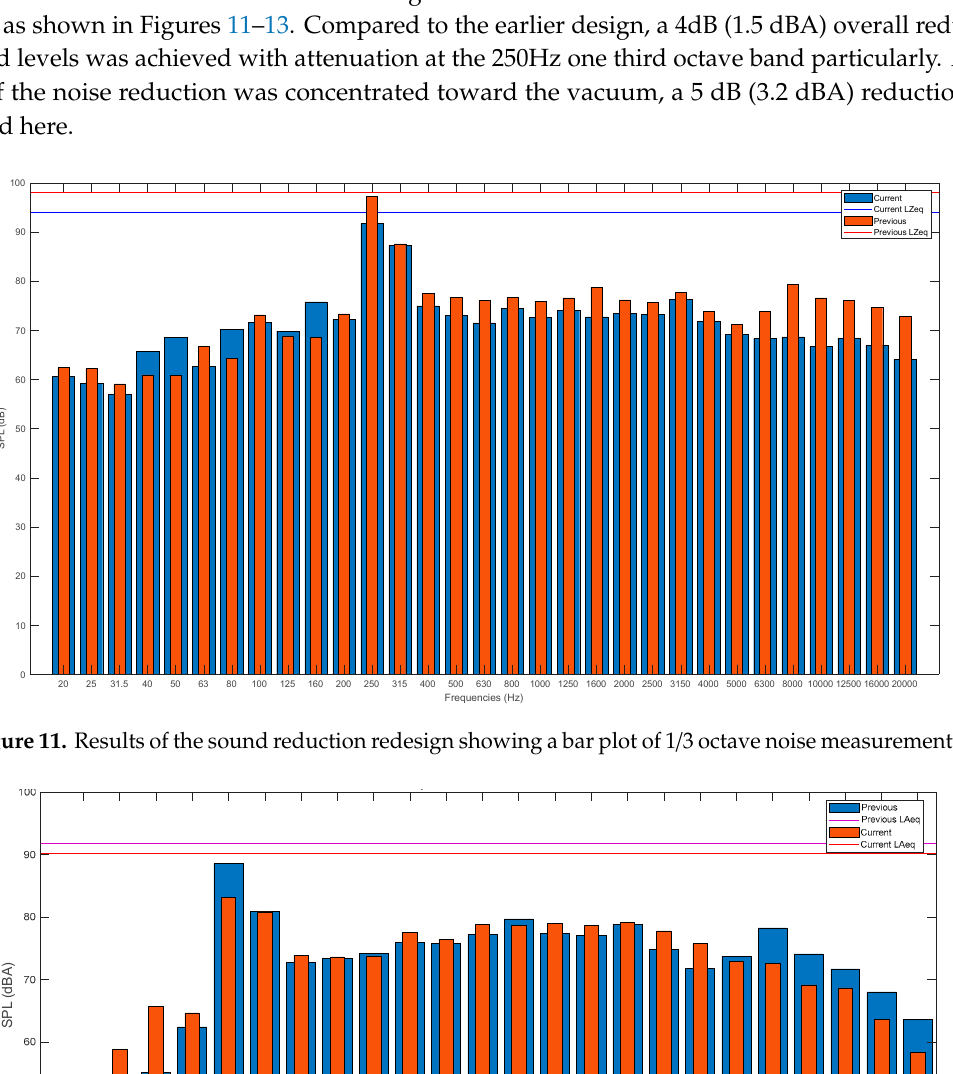
Figure 13. Results of the sound reduction redesign on the vacuum showing a bar plot of 1/3 octave noise measurements with dBA weighting.